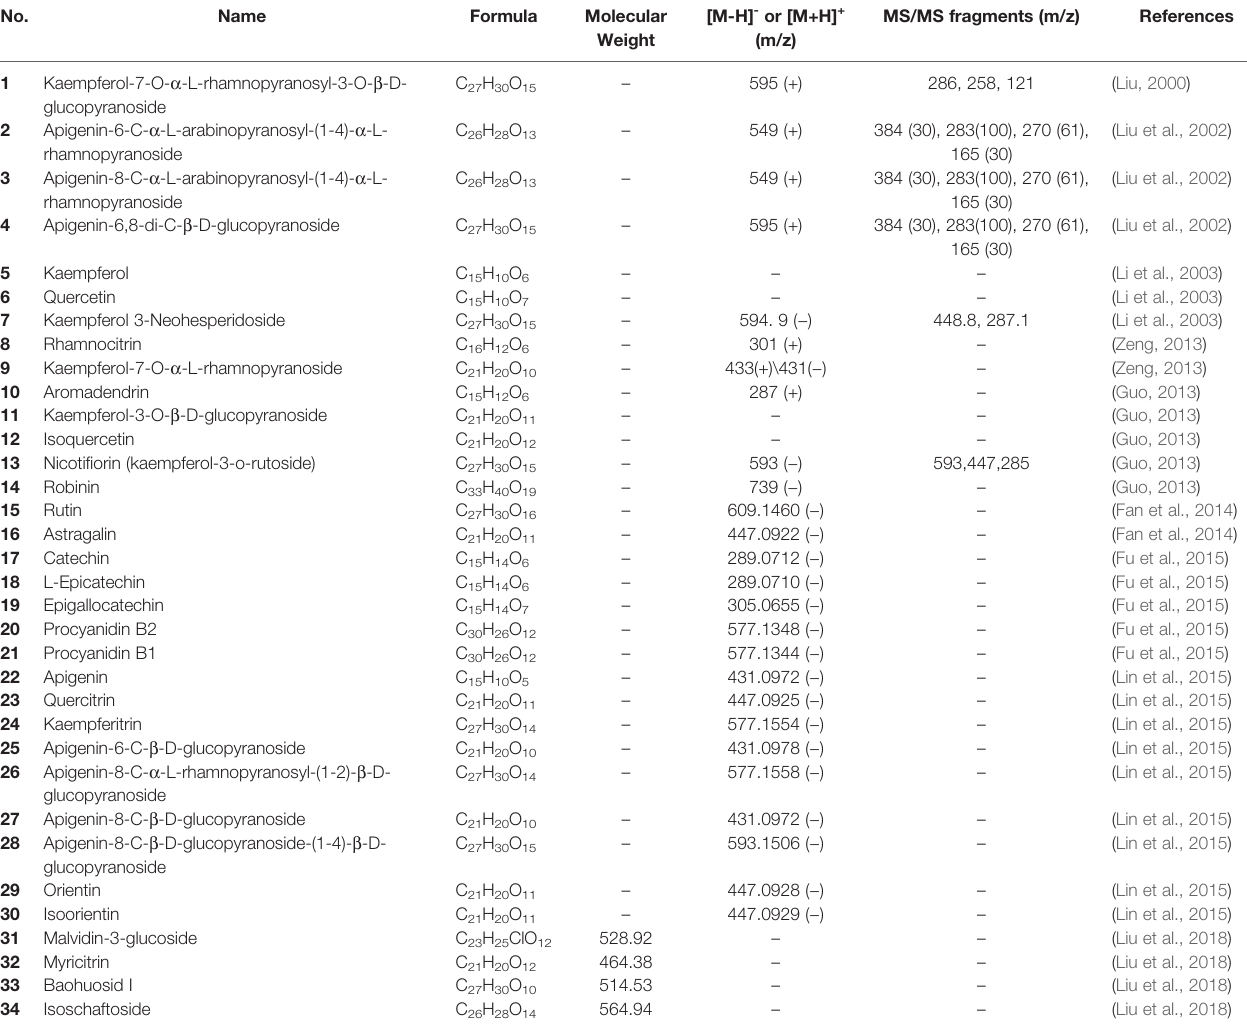
TABLE 1 | Flavonoids isolated from Tetrastigma hemsleyanum Diels & Gilg.